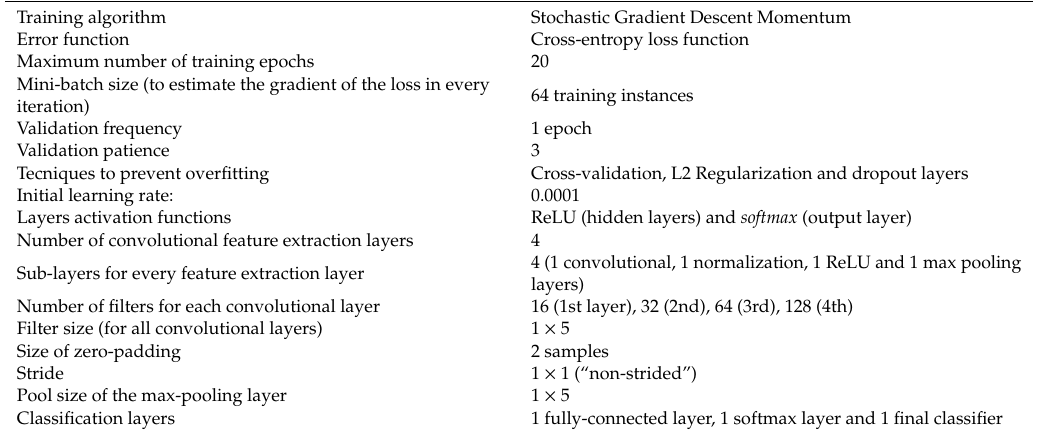
Table 5. Architecture and training hyper-parameters of the employed CNN.